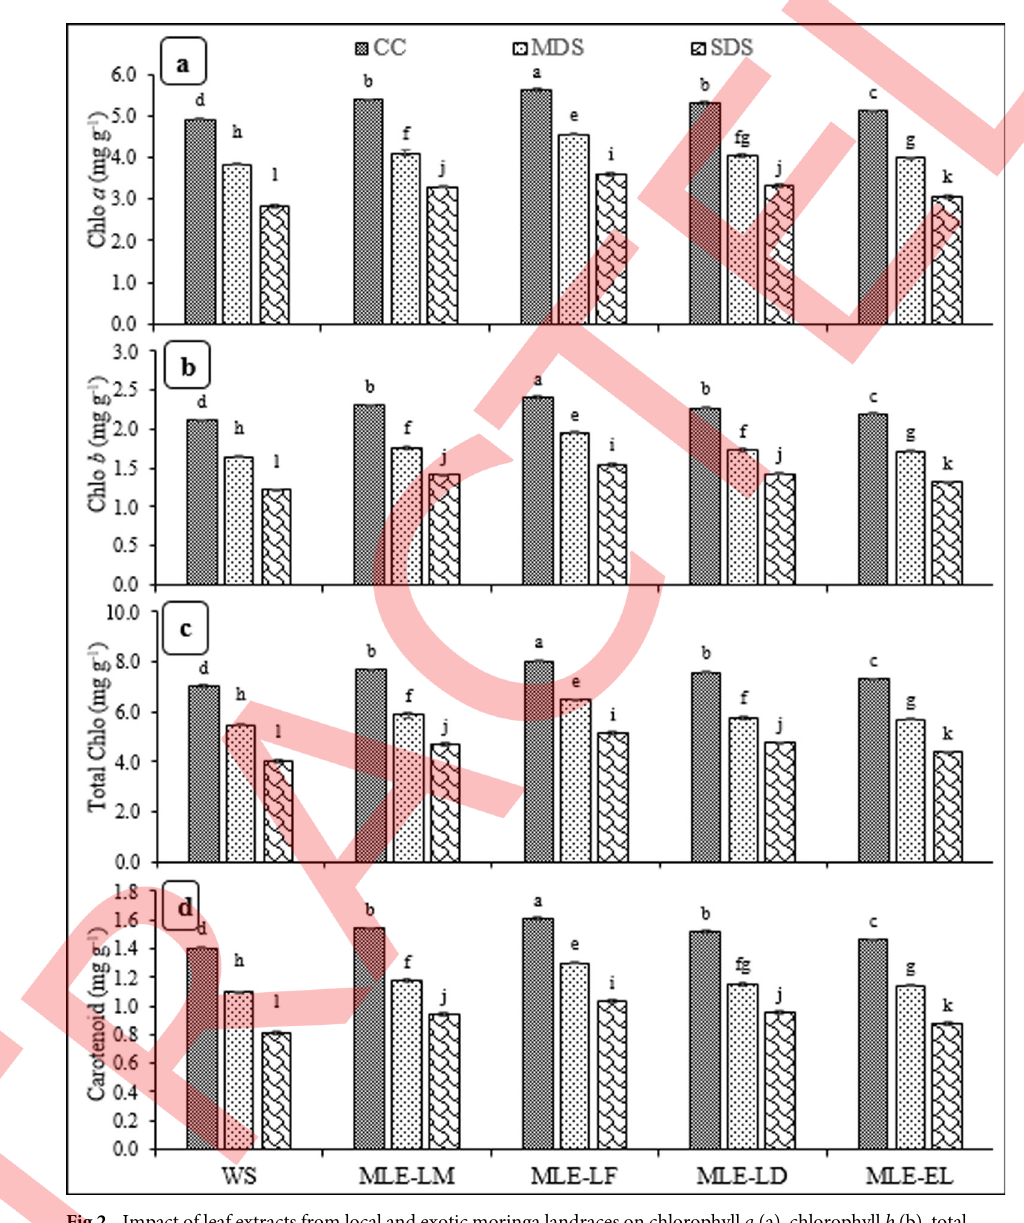
Fig 2. Impact of leaf extracts from local and exotic moringa landraces on chlorophyll a (a), chlorophyll b (b), total chlorophyll (c) and carotenoid contents (d) of rice leaf cultivated under normal and drought-stressed environments (n =